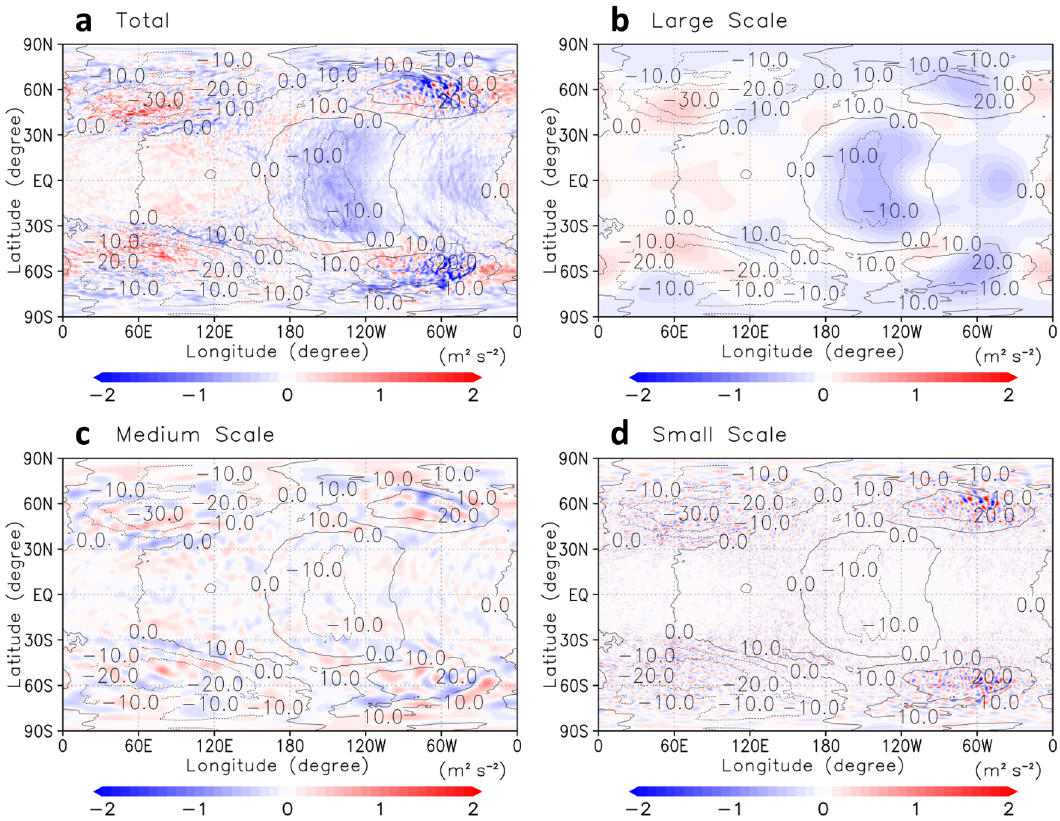
Fig. 4 Vertical momentum fl ux. a – d Longitude – latitude cross-sections of composite-mean vertical momentum fl ux (m 2 s – 2 ) at the cloud-top (~70 km) level with different resolved scales, total (0 (cid:5) k (cid:5) 639), large-scale (0 (cid:5) k (cid:5) 9), medium-scale (10 (cid:5) k (cid:5) 49) and small-scale (50 (cid:5) k (cid:5) 159) ones, respectively. Here, k denotes a horizontal wavenumber. Zonal fl ow disturbances from its zonal average (black contours; intervals are 10 m s − 1 ) are also shown. The subsolar point is located at the centre of each panel, (180°E,